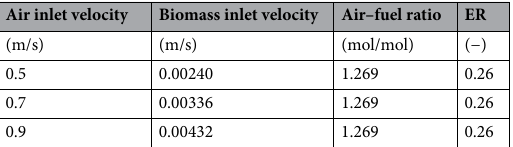
Table 4. Gas inlet velocity and biomass inlet velocity investigated in the simulations.